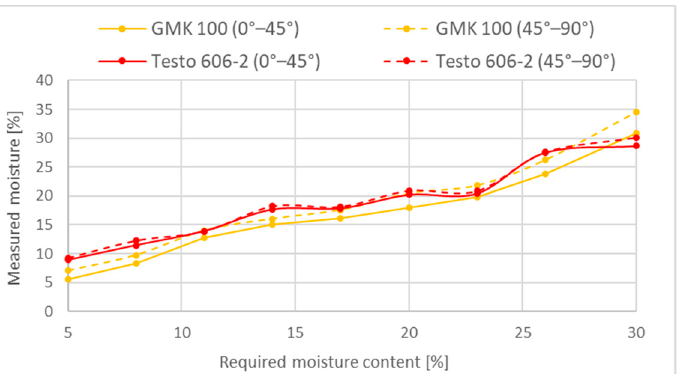
Figure 11. Comparison of the measured values of the moisture meters (GMK 100, Testo 606-2) on the MC of softwood (S—spruce) in the transverse direction in the moisture range of 5% to 30% with respect to the ring deflection in the range of 0°–45° (radial) and 45°–90° (tangential).